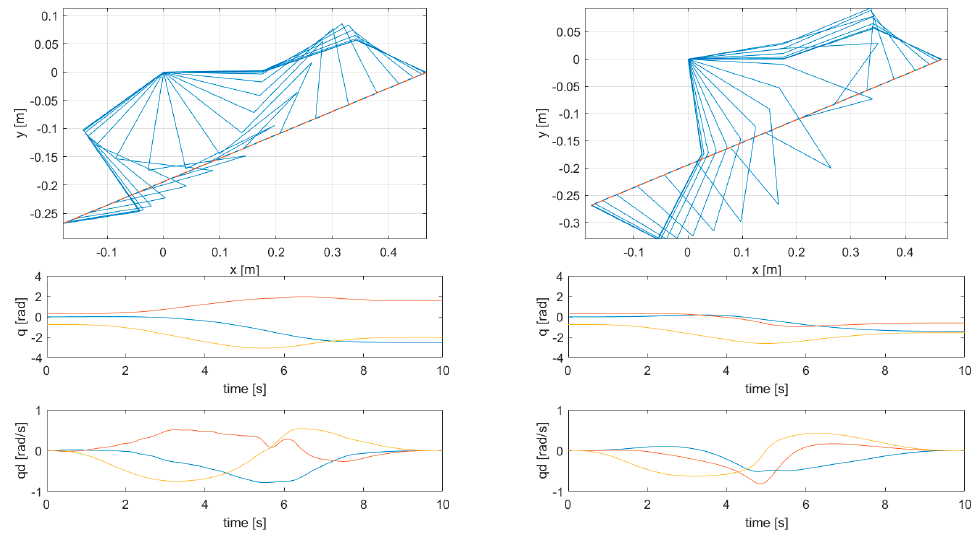
Figure 7. Trajectory 4, comparison between PMKE ( left ) and LSV ( right ). First joint: blue lines; second joint: red lines; third joint: yellow lines.